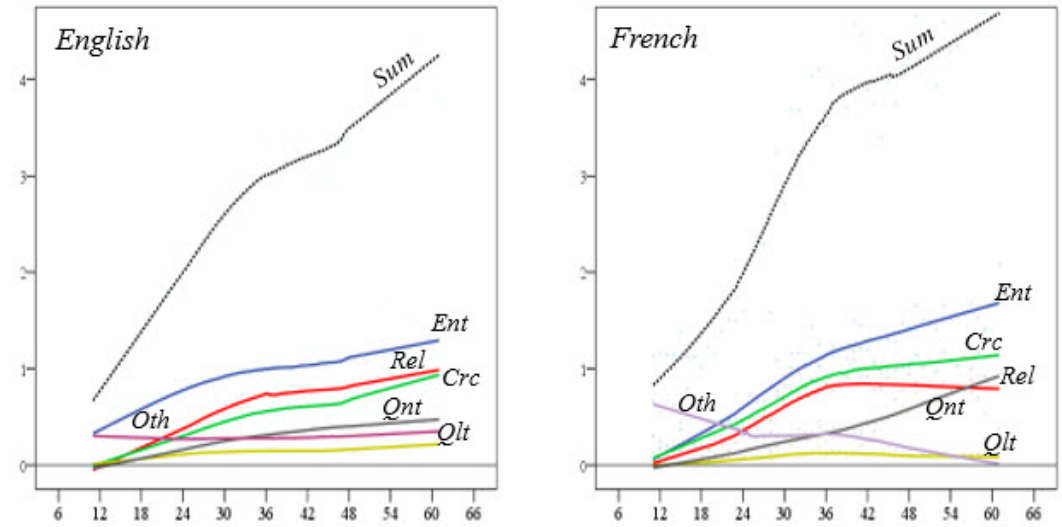
Figure 4. Meaning classes’ use with advancing age : Ent – Entities, Rel – Rela- tionships, Crc – Circumstances, Qlt – Quality, Qnt – Quantity, Oth – Others, Sum of all classes (Sum of POS Table 4. Correlations of the use of